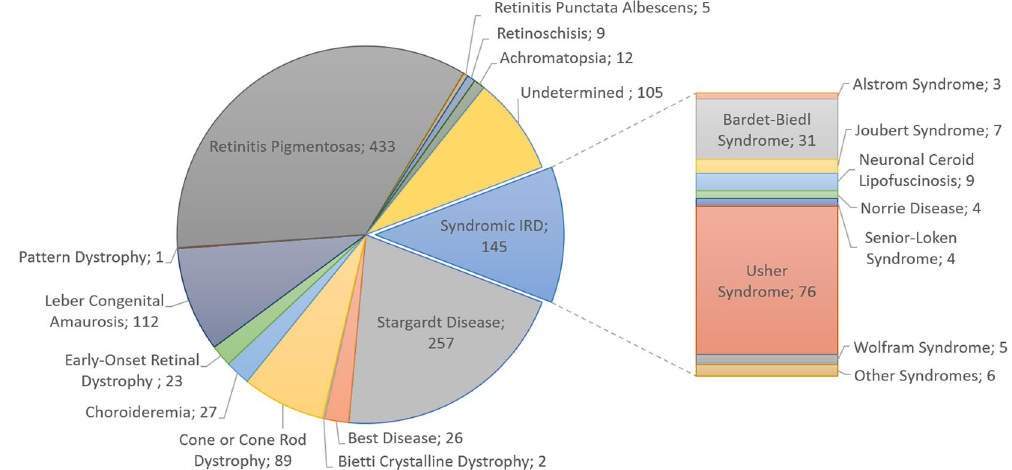
Figure 1. The distribution of patients according to their clinical diagnoses (n = 1,246). The syndromic IRD cases are grouped in the pie chart, and detailed in the stacked bar on the right. Arts syndrome, Hallervorden- Spatz disease, Jalili syndrome, Marshall syndrome, Microcephaly and chorioretinopathy and PHARC syndrome (Polyneuropathy, Hearing loss, Ataxia, Retinitis pigmentosa, and Cataract) are designated as “other syndromes”.